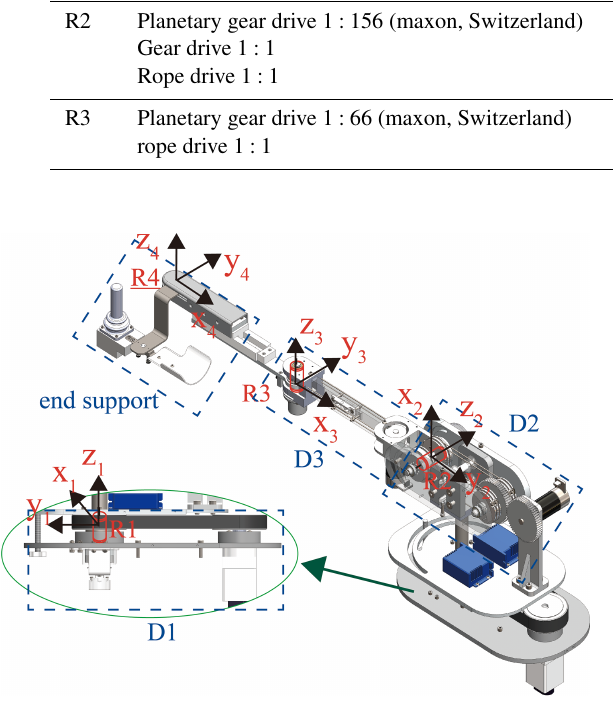
Figure 2. The structure of the end-effector-based upper limb reha- bilitation